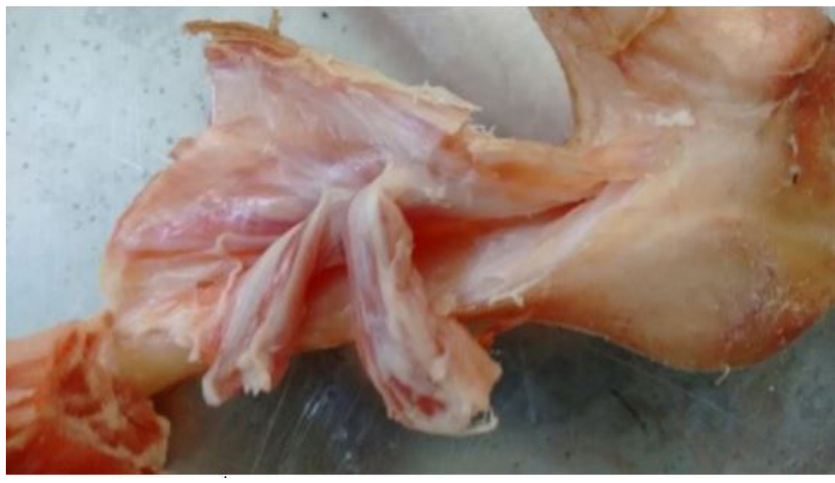
Figure 9. Atrophied